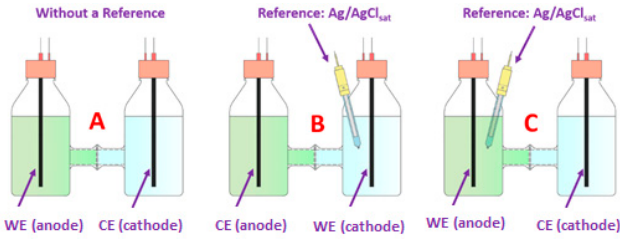
Figure 2. Potentiostat settings for cyclic voltammetry (CV) measurements.